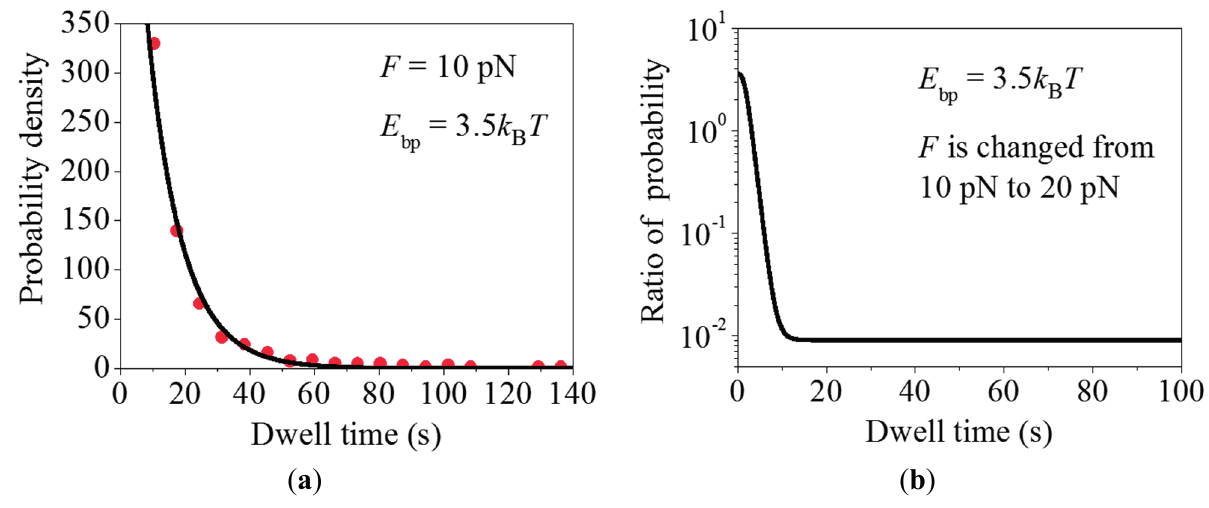
Figure 2. Dynamics of long pauses. ( a ) Distribution of dwell times with long durations (>7 s). Line represents the theoretical results calculated with F = 10 pN and E bp = 3.5 k B T and